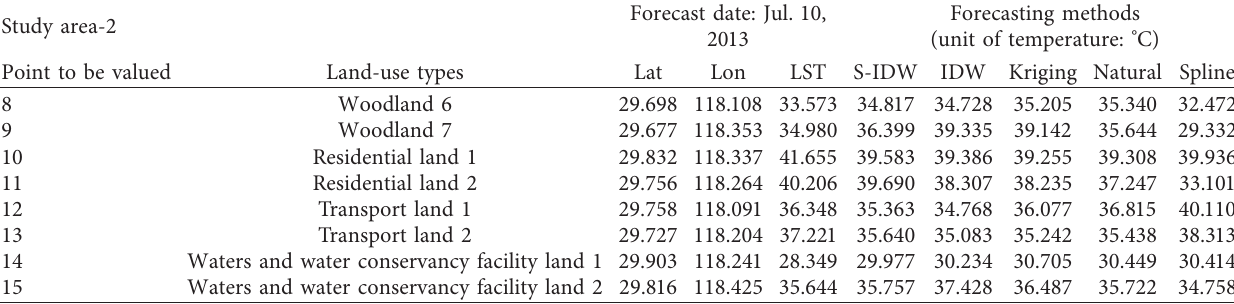
Table 19: Comparison of interpolation accuracy of 5 kinds of interpolation methods on Jul. 10, 2013. Study area Forecasting methods